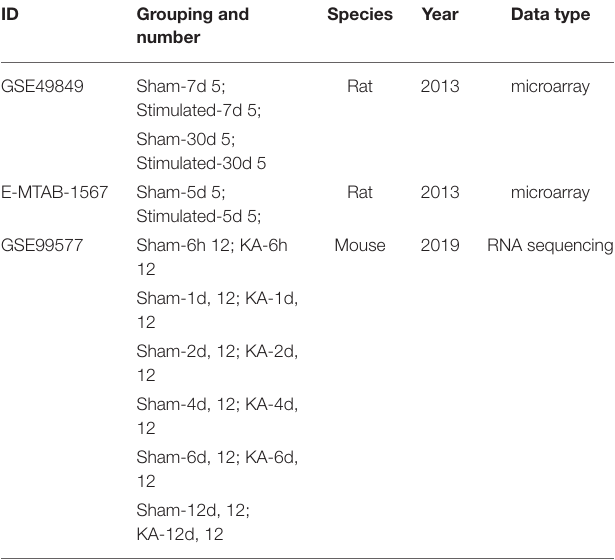
TABLE 1 | Characteristics of the datasets in our